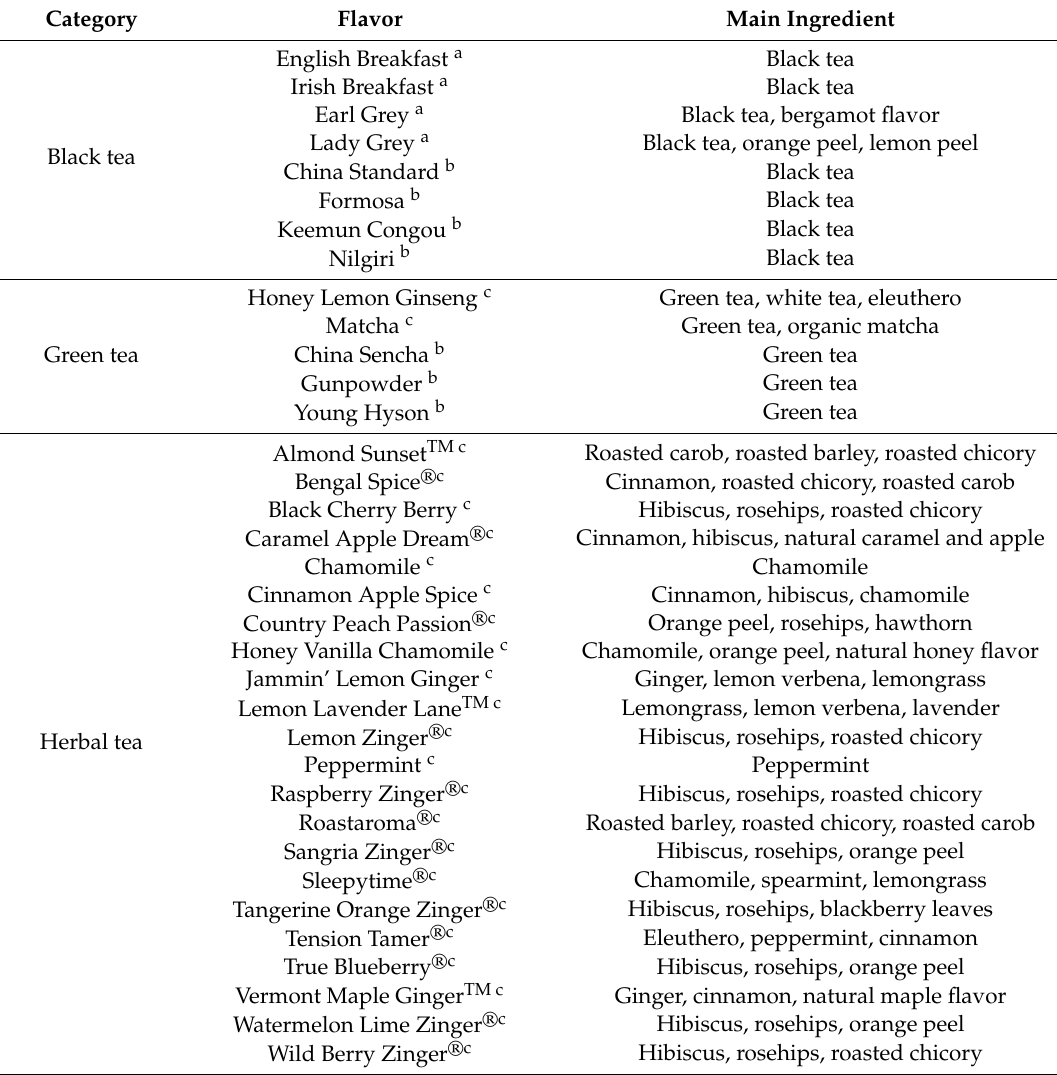
Table 1. Detailed descriptions of the investigated teas in this